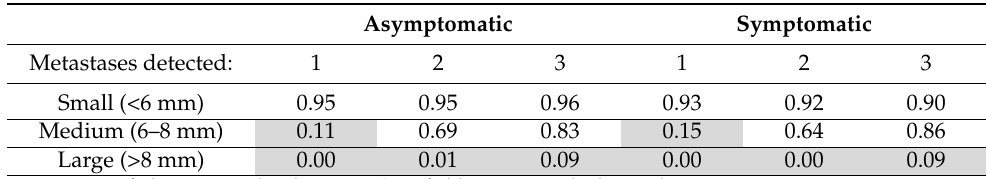
Proportions of oligo+ per risk sub-group. Grey fields represent the low-risk group. Table A13. Proportion of oligo+ within patients with detected oligo-metastases in the redefinition of oligo metastases to 1 metastasis scenario.